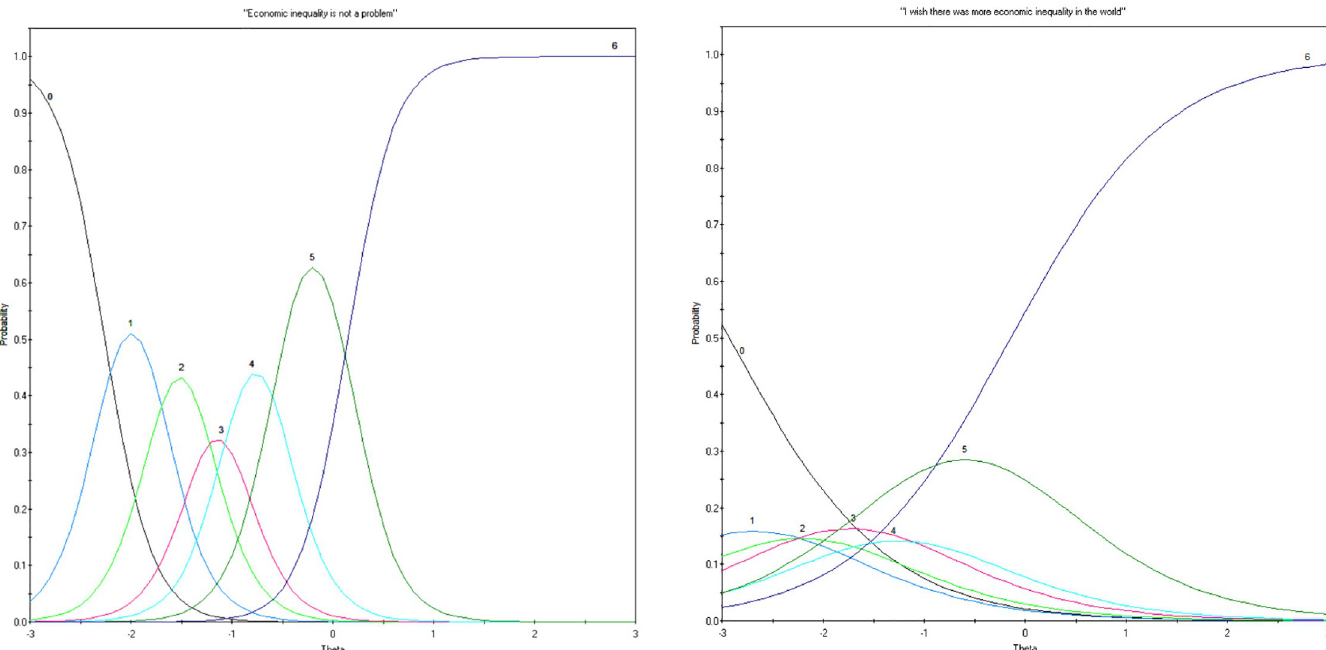
Fig 1. Examples of item characteristic curves from Study 1. (A) A well-defined Item Characteristic Curve; item 10. (b) A poorly-defined Item Characteristic Curve; item 13.